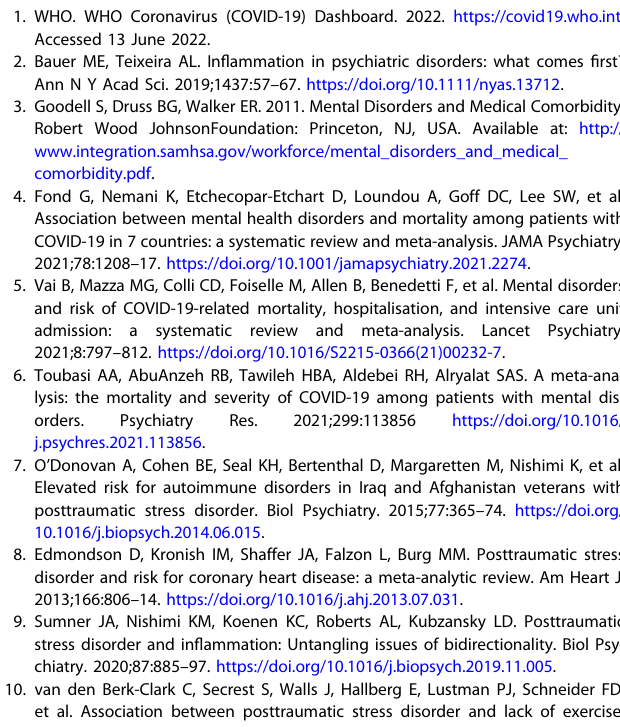
for psychiatric comorbidities to identify individuals at higher risk for hospitalization and death following COVID-19. Accumulating data linking psychiatric disorders with COVID-19 disease outcomes underscore the need to coordinate across disciplinary boundaries to improve public health in the context of the COVID-19 pandemic.